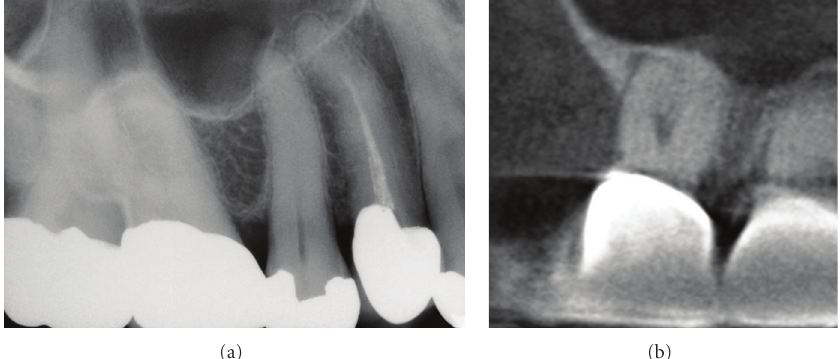
Figure 12: Di ffi culty in visualizing furcal and apical lesions with periapical radiography due to lack of coverage, anatomic superimposition, and geometric distortion is well established. The periapical radiograph (a) of the maxillary right second molar in an asymptomatic patient is unremarkable; however there is lack of coverage of the second molar posteriorly and marked superimposition of the distal root of the first molar over the mesial root of the second molar. The corresponding cropped sagittal CBCT image (b) of the second molar demonstrates a furcal radiolucency and associated periradicular periodontitis. Subsequent clinical investigation found this tooth to be